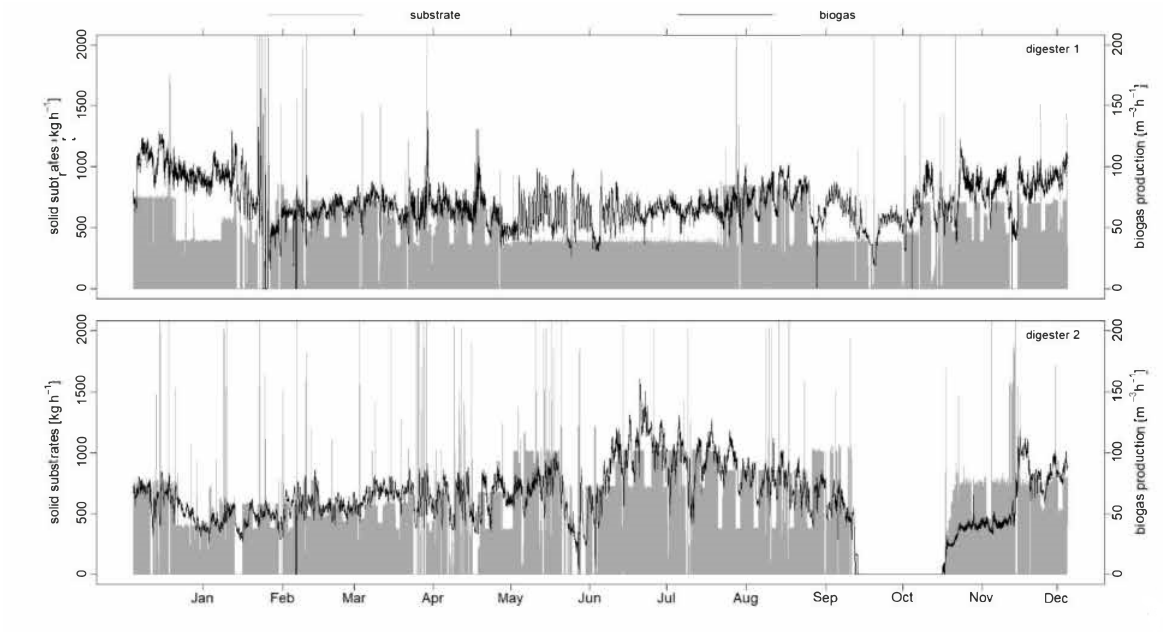
Figure 1. Solid substrate supply and biogas production from digester one ( top ) and digester two ( bottom ) in 2018 in hourly